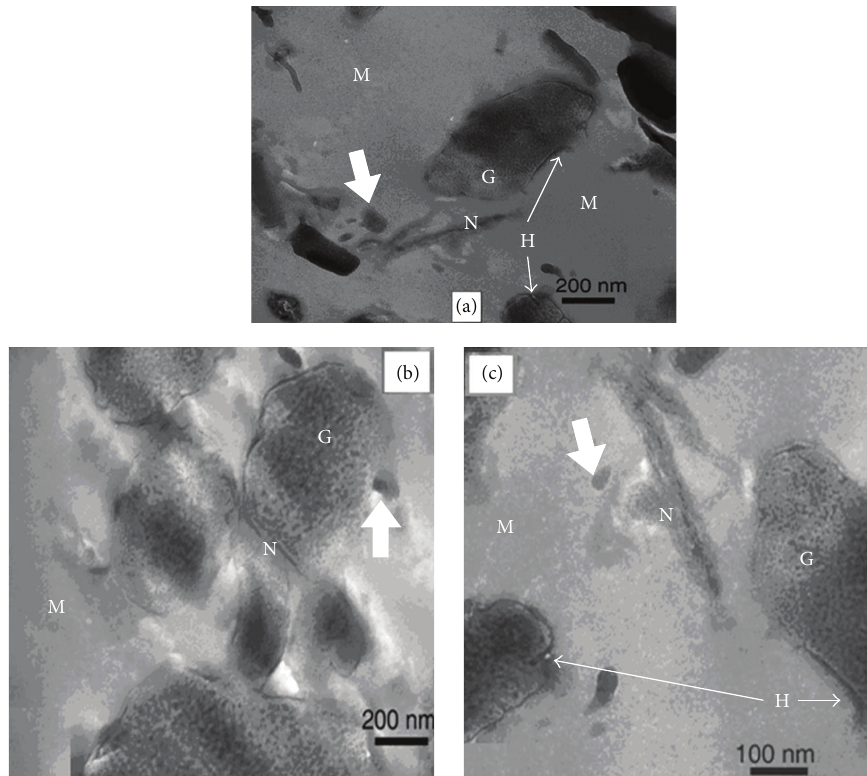
Figure 6: TEM micrographs of Fuji-IX cement after the dispersion of 2% nanoclay in liquid portion (C-N) showing the interaction of nanoclays within GIC system, ((a) and (b)) at lower magnification and (c) at higher magnification indicating remnant glass core (G), nanoclay (N), siliceous hydrogel layers around the periphery of glass filler core (H), cement matrix (M), and fully reacted hydrogel within the matrix (white bold